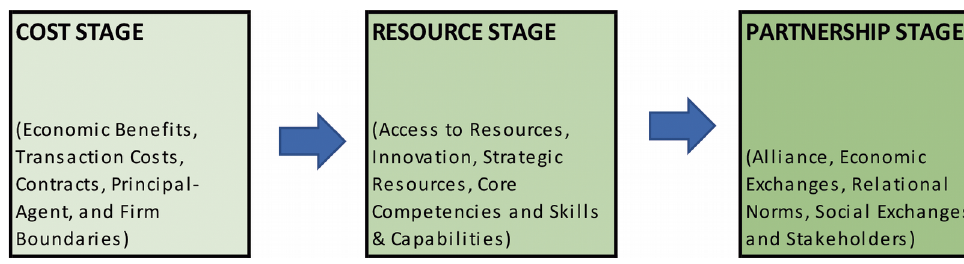
Figure 1. Maturity model (Gottschalk & Solli-Sæther,